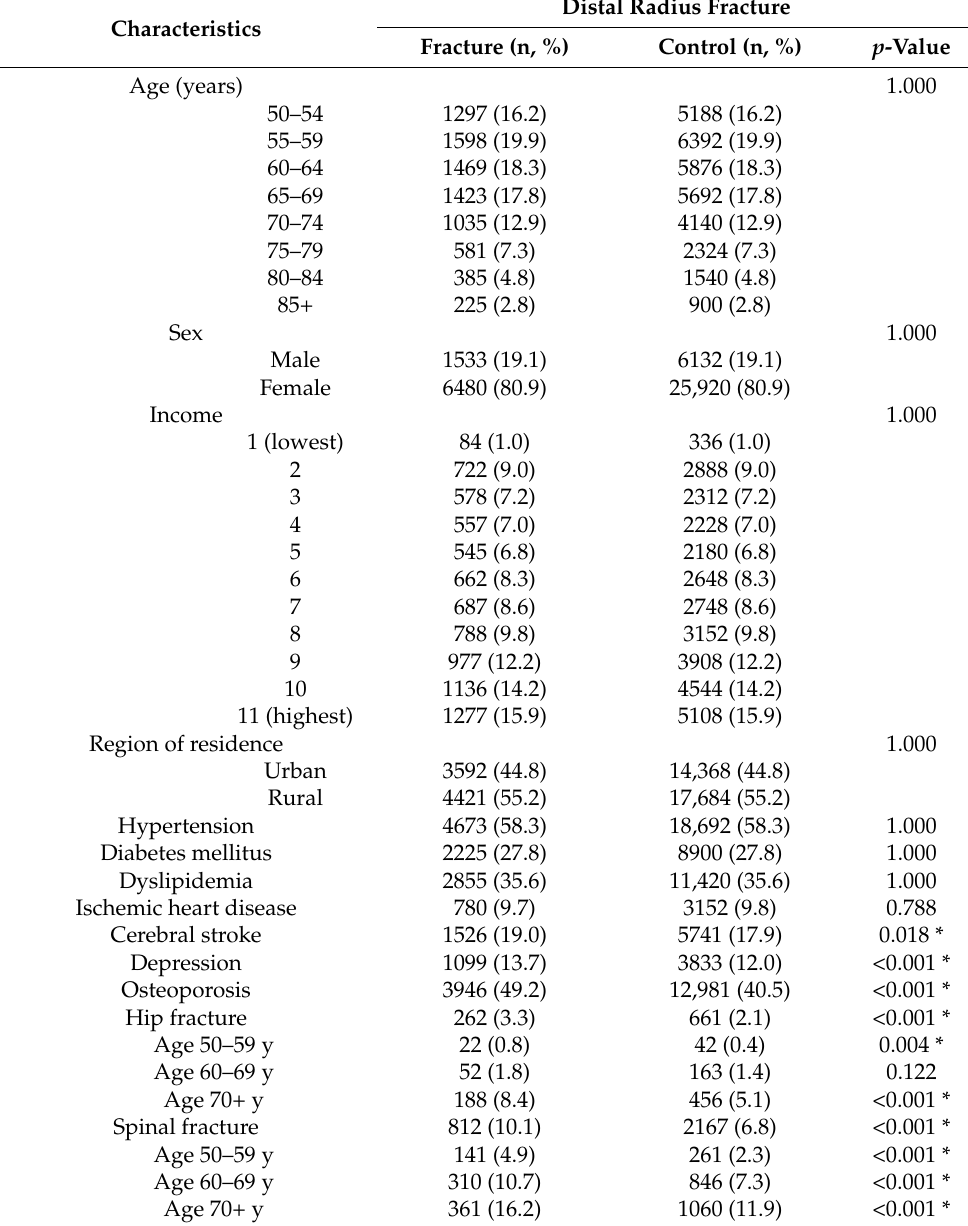
Table 1. General characteristics of